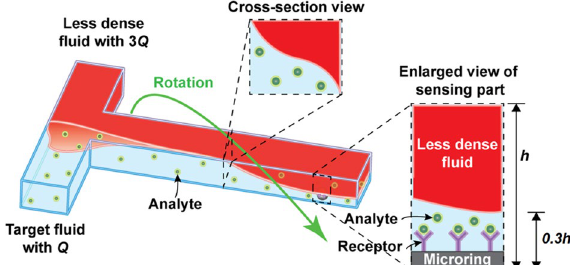
Figure 1. Schematic diagram of the RFF method’s concept. An injected target fluid is rotated by adding a less-dense fluid faster than the target fluid. In cross-section views at various locations, flow-twisting is observed. Injected analytes are rotationally focused near immobilised receptors onto a microring resonator by the relationship between flow rate and dynamic viscosity of a target fluid and a less-dense fluid. For example, if the volumetric flow rate of less-dense and target fluids is 3 Q : Q and the dynamic viscosity of less-dense and target fluids are 5:4 in Eq. (1), the height of the target fluids is reduced to 0.3 of the height of a